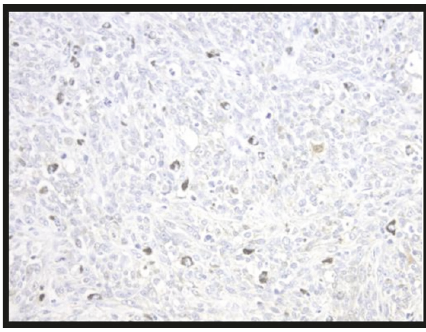
Figure 4: Histological Specimens of Gastric Melanoma. Primary gastric melanoma positive stain for S100. Weak and high intensity staining are seen throughout the section (H&E